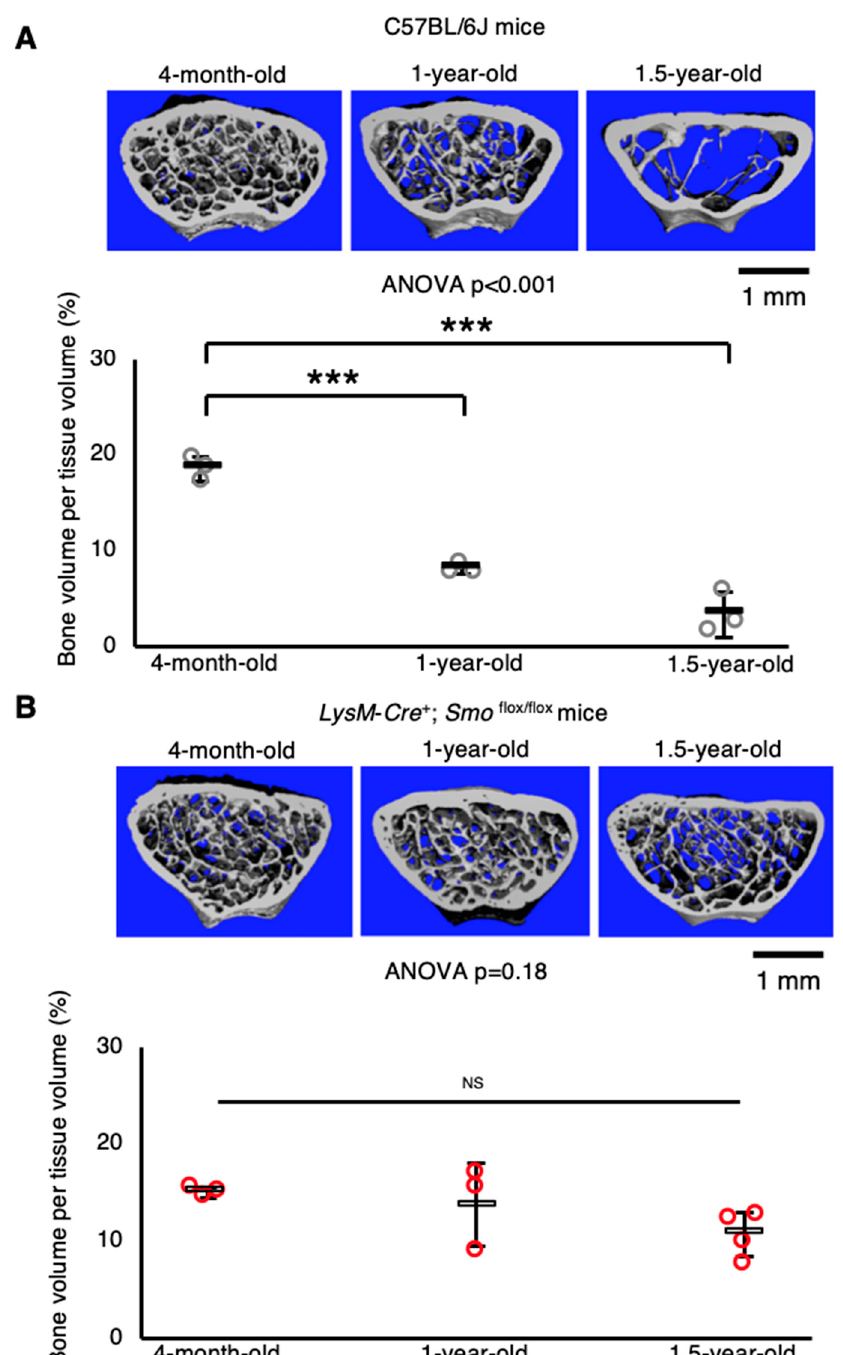
Figure 5. Macrophage / osteoclast lineage-specific Smo knockout mice exhibit resistance to age-related bone loss. ( A , B ) Distal femurs from ( A ) C57BL / 6J male mice or ( B ) LysM-Cre + ; Smo flox / flox male mice scanned in a Scanco Medical µ CT 35 System (SCANCO Medical); representative images and three-dimensional bone volume per tissue volume (%) ( n = 3–4). Data are represented as means ± s.d. One-way ANOVA, followed by Dunnett’s test; NS, not significant, and *** p < 0.001. Note that we separated C57BL / 6J mice and LysM-Cre + ; Smo flox / flox mice datasets, because we maintained C57BL / 6J mice and LysM-Cre + ; Smo flox / flox mice separately.